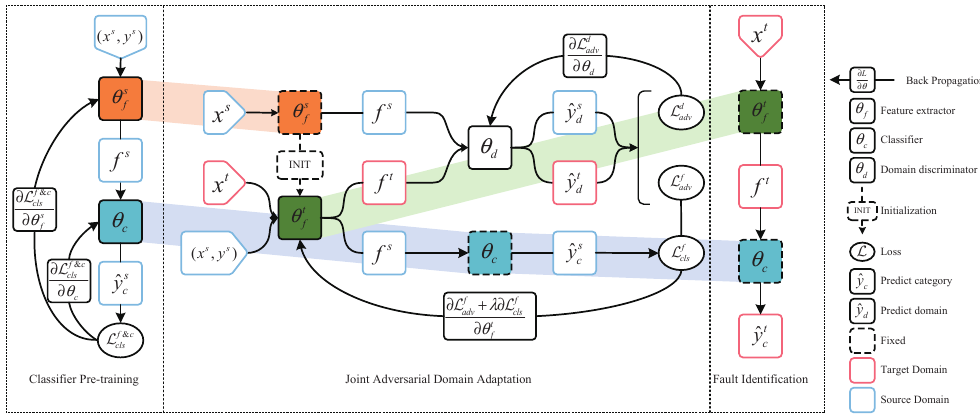
Figure 1. Fault diagnosis process of